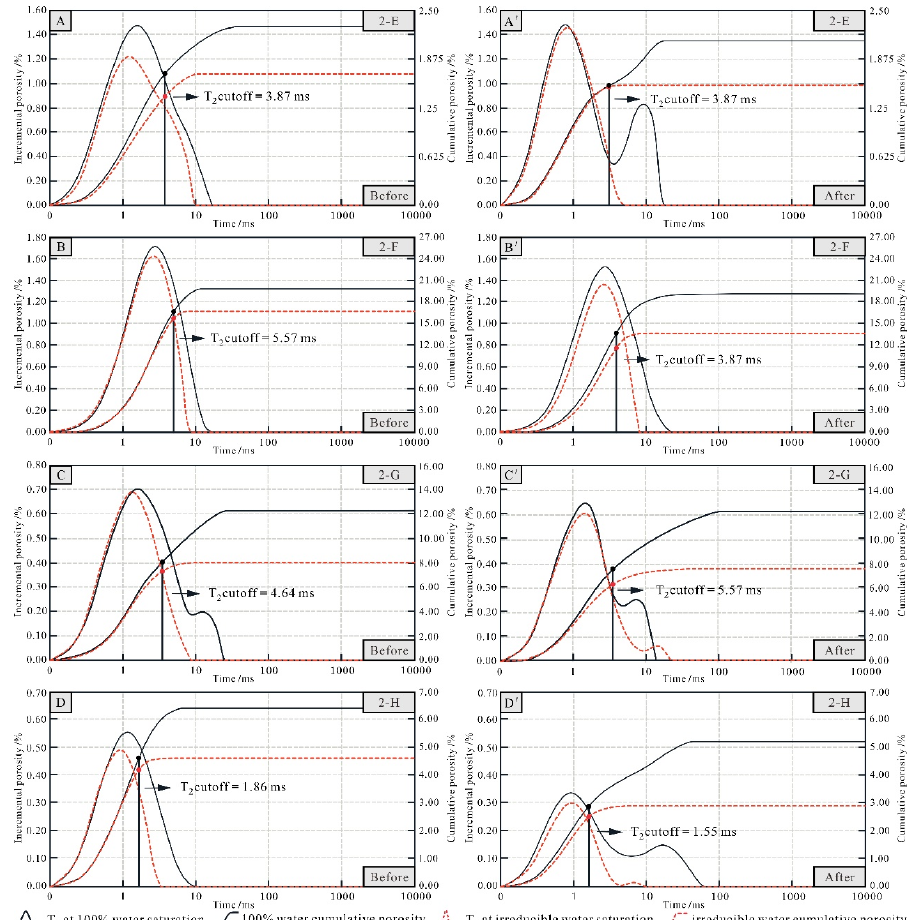
Figure 8. NMR T 2 spectrum distribution of the selected mixed siliciclastic-carbonate rocks. ( A )–( D ): T 2 spectrum distribution before acidification; ( A' )–( D' ): T 2 spectrum distribution after acidification.